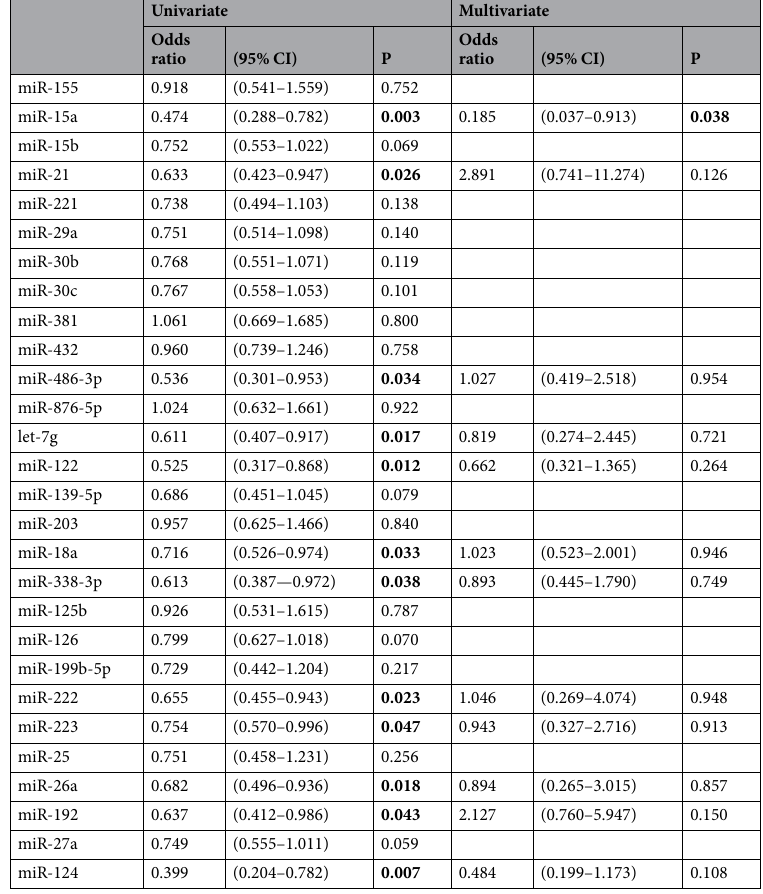
Table 2. Association of miRNA levels with HCC using the logistic regression